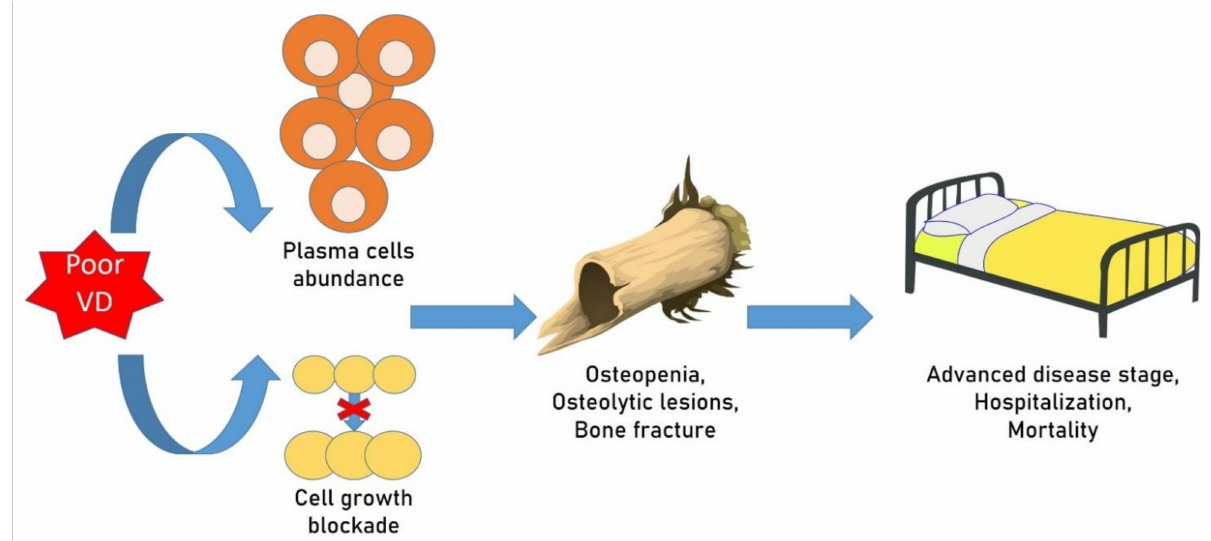
Figure 4. Osteoporosis, vitamin D, and monoclonal gammopathies. VD deficiency influences the onset of an alteration of bone metabolism with secondary osteoporosis or the appearance of bone fractures and lytic lesions. The reduction in VD levels causes the disappearance of the plasma cell proliferation block normally induced by